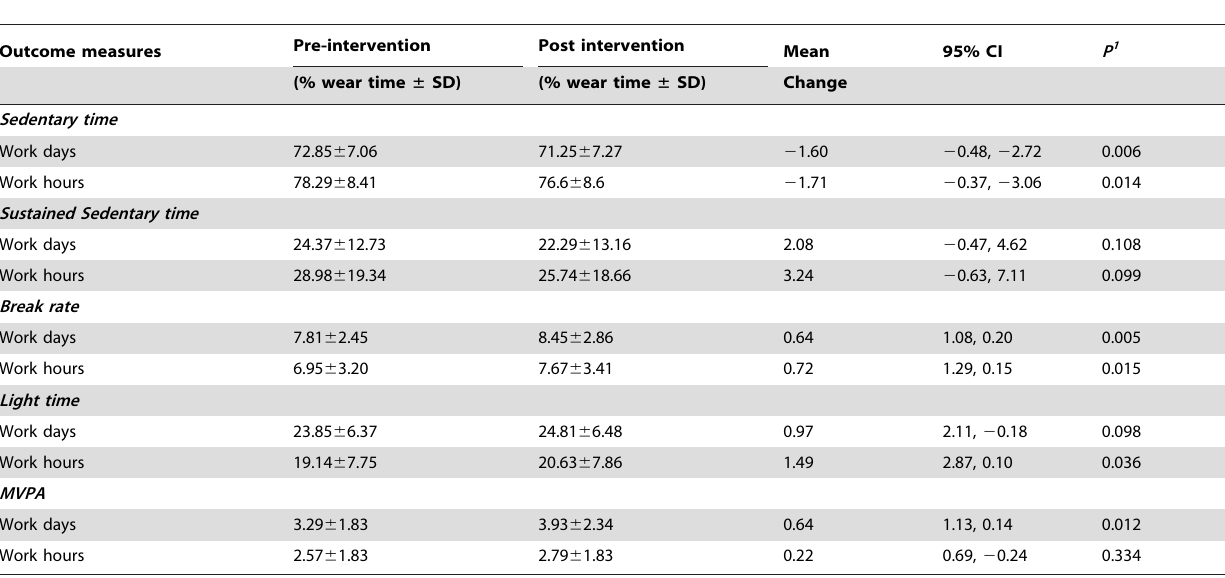
Table 3. Sedentary time, light activity, MVPA, sustained sedentary time (bouts . 30 mins) and break rate (breaks/sedentary hour) for all participants before and after